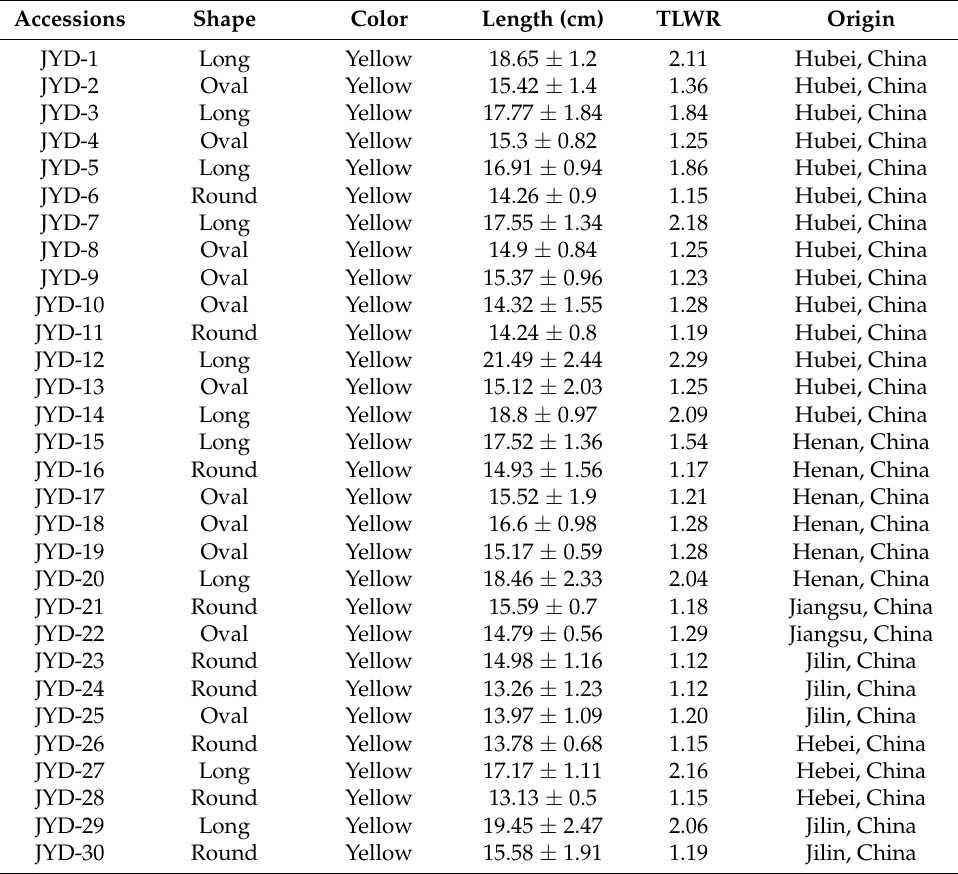
Table 1. Tuber traits of tiger nut accessions used in the